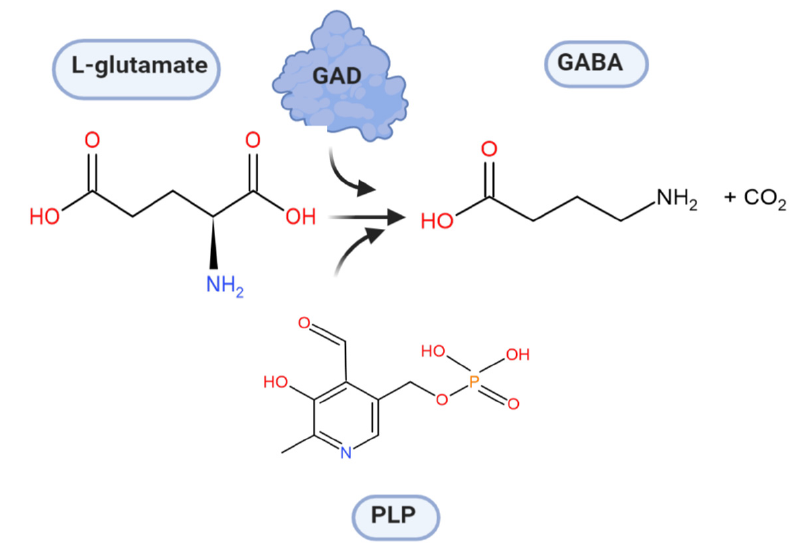
Figure 1. Decarboxylation of L -glutamate to GABA catalyzed by glutamate decarboxylase. PLP: pyridoxal-5 ′ -phosphate.